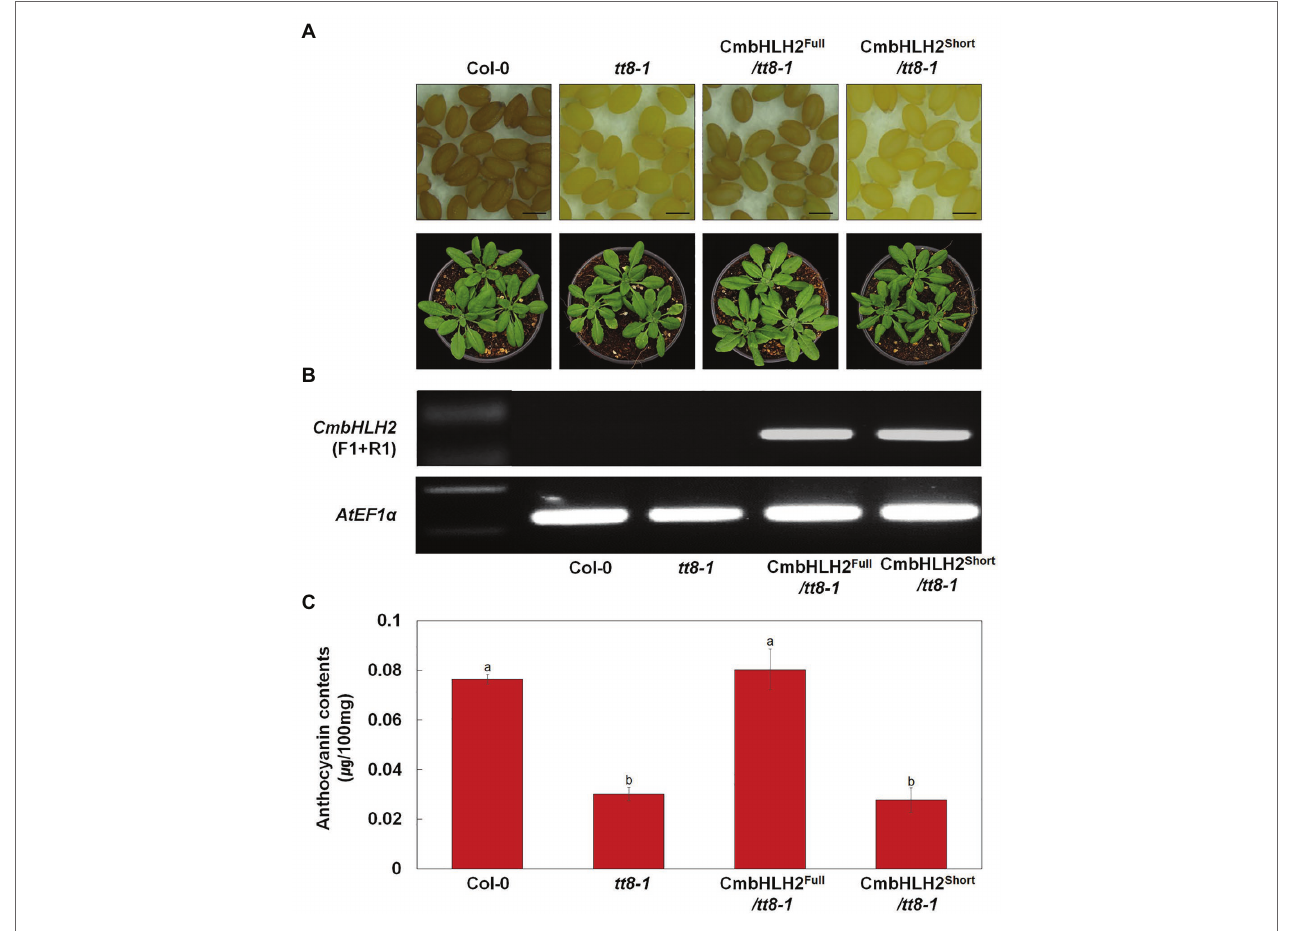
FIGURE 9 | Overexpression of CmbHLH2 Full and CmbHLH2 Short in Arabidopsis tt8-1 mutants. (A) Seeds (top) and 4-week-old seedlings (bottom) of wild-type Col-0, tt8-1 , and representative T 2 progeny of homozygous Arabidopsis tt8-1 lines transformed with CmbHLH2 Full and CmbHLH2 Short , respectively. Scale bar indicates 0.1 mm. (B) Expression analysis of CmbHLH2 in the leaves of wild-type, tt8-1 , and transgenic plants by RT-PCR. AtEF1 α was used as the reference gene. (C) Anthocyanin content of four-week-old Arabidopsis plants. Results represent mean values ± SD from three biological replicates. Different letters above the bars indicate significantly different values ( p < 0.0001) calculated using one-way ANOVA followed by Duncan’s multiple range